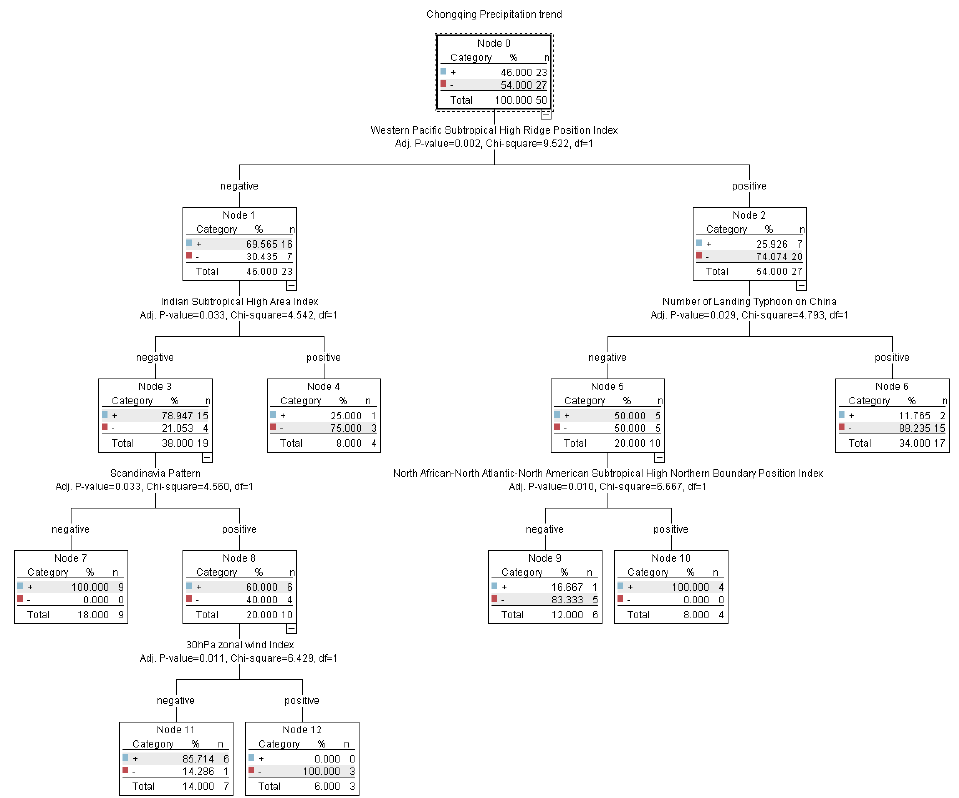
Figure 2. An analytic diagram of the relationship between the precipitation trend and circulation index in summer in Chongqing based on the CART algorithm. The ‘% ‘represents the probability of more or less. The ‘n’ represents more or less annual scores (as